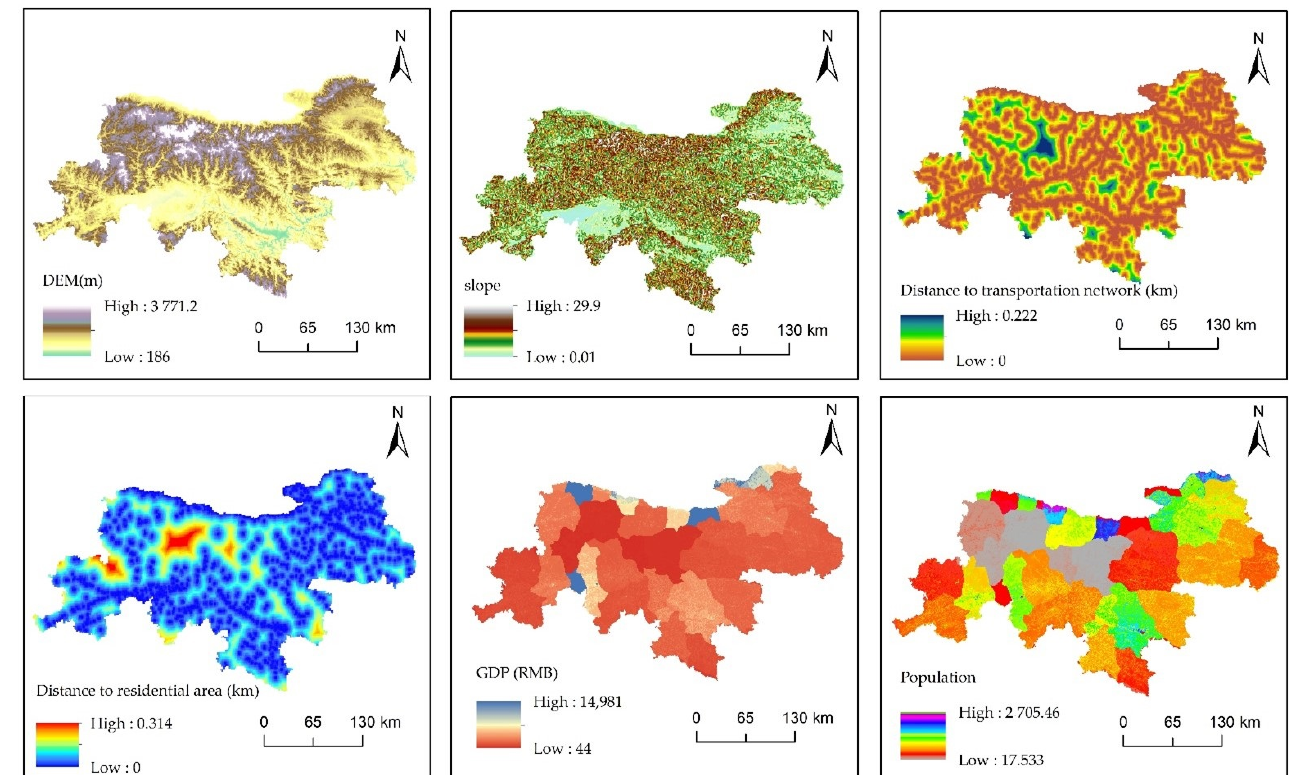
Figure 5. Spatial data set of driving factors for land-use type simulation.